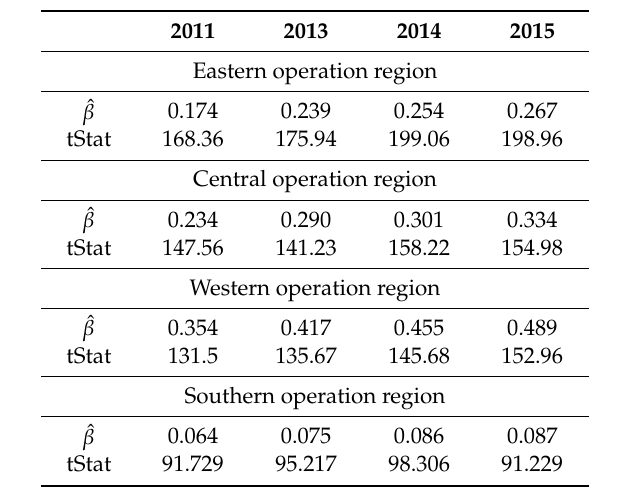
Table A2. Details of OLS regression